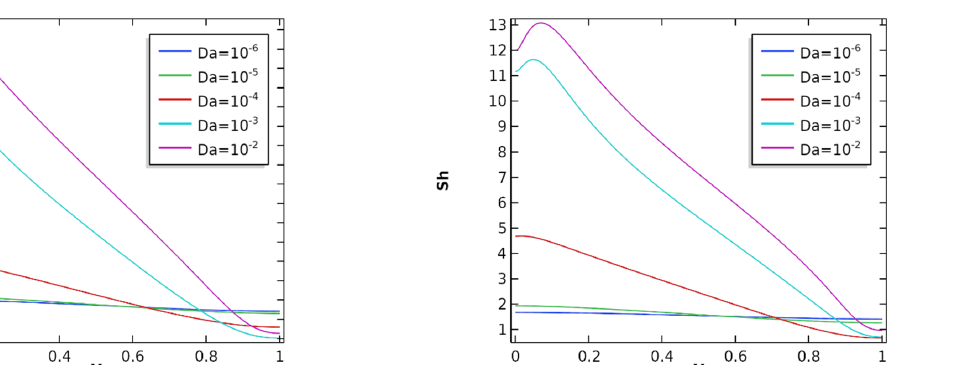
Figure 9. Streamlines (column 1), isotherms (column 2), and isoconcentration (column 3).